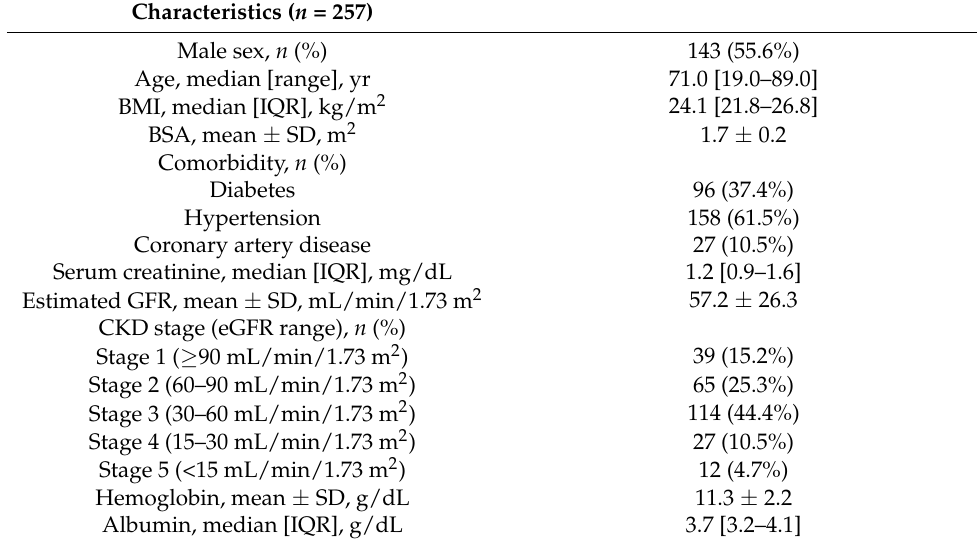
Table 1. Characteristics of the